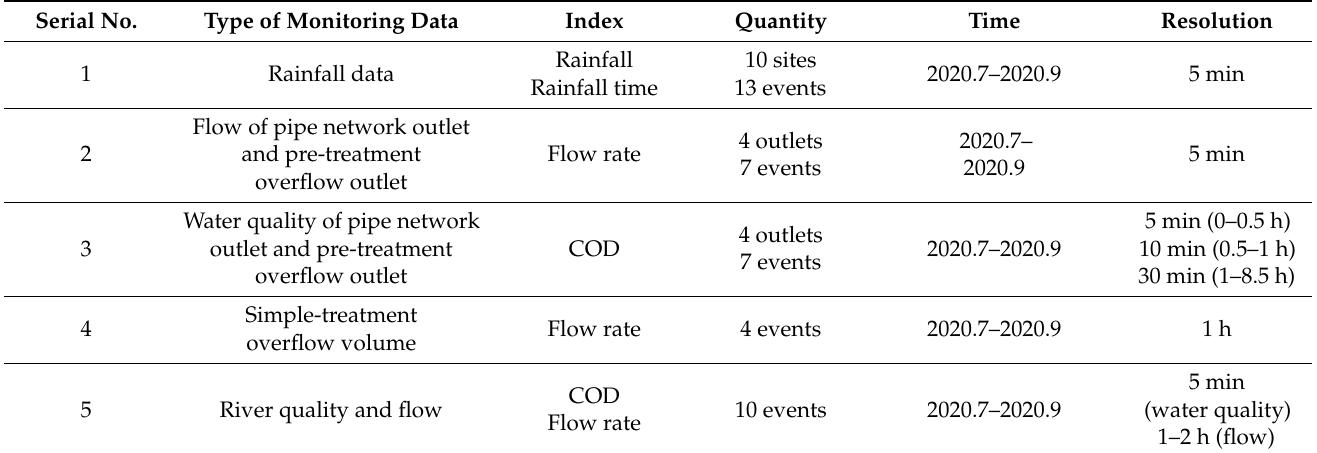
Table 2. Summary of monitoring data.